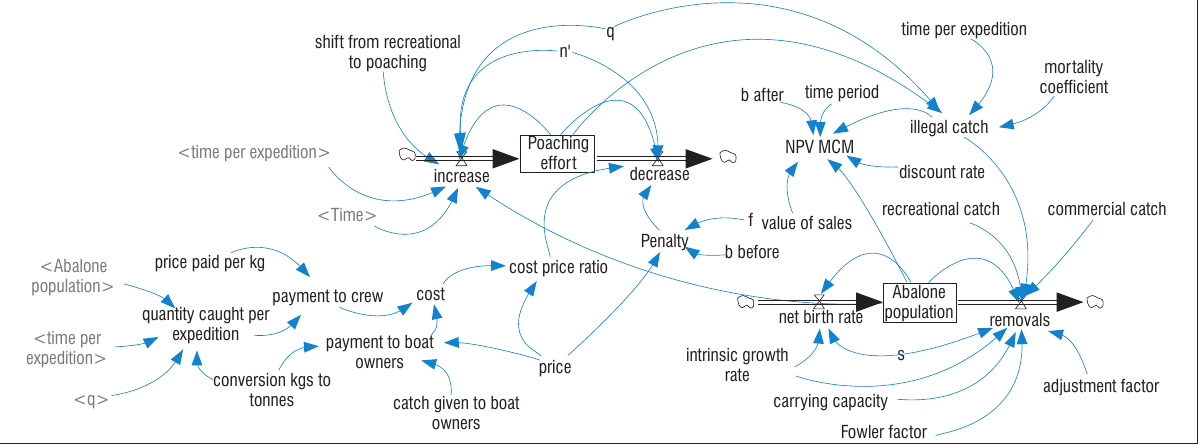
Figure 2: Stock flow diagram for the abalone fishery.